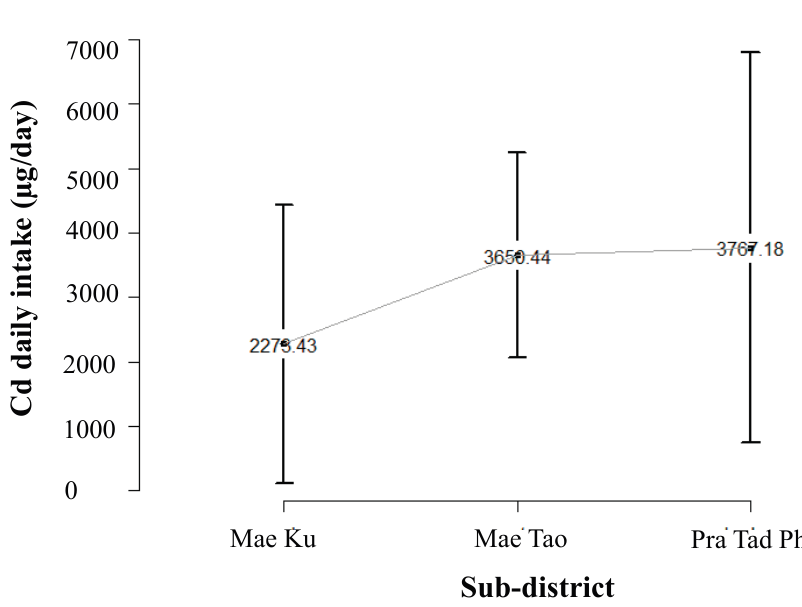
Figure 3. Distribution of cadmium (Cd) daily intake in surveyed paddy fields in Mae Sot areas: paddy fields in Mae Ku (mean = 2273 µg/day, 95% CI = 115–4430)), Mae Tao (mean = 3650 µg /day, 95% CI = 2060–5241) and Pra Tad Pha Dang (mean = 3767 µg/day, 95% CI =